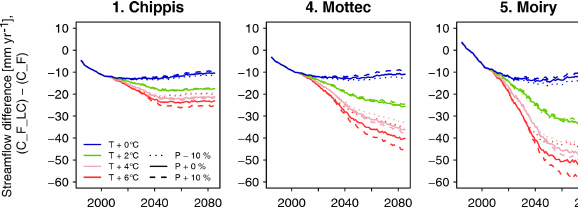
Figure 11. Difference in simulated annual streamflow (30-year rolling means) between the standard fully coupled runs (C_F) and the coupled runs with land abandonment (C_F_LC) for three con- trasting subcatchments. In the land abandonment scenario, forest is allowed to grow in all cells classified as meadows and alpine vegetation. The Chippis subcatchment has relatively few meadows, whereas they occupy about a third of the high-elevation catchment Moiry (see Fig. 2). Forest expansion leads to streamflow reduction due to the higher leaf area and potentially deeper roots. As most meadows are located at high elevations, the effect of forest expan- sion on streamflow greatly depends on the warming